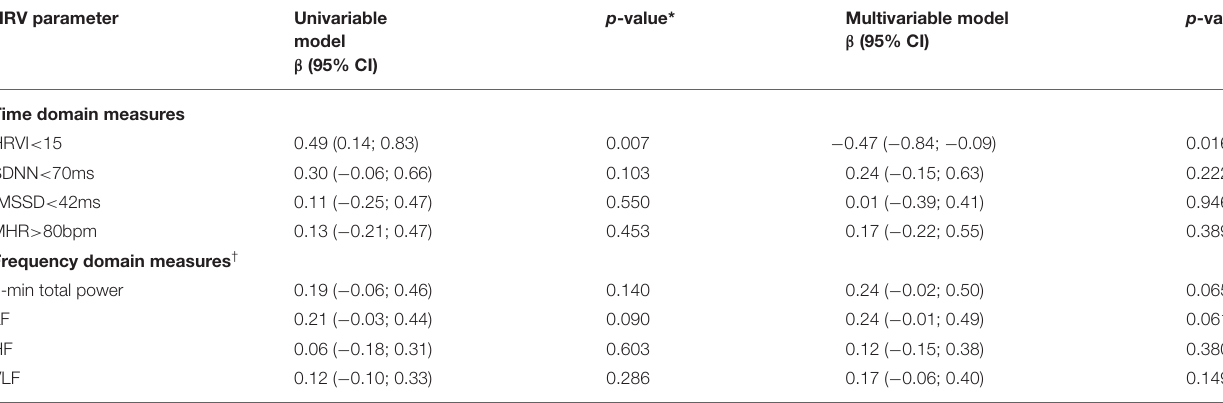
TABLE 4 | Association of heart rate variability and silent brain infarct volume in the sinus rhythm group.